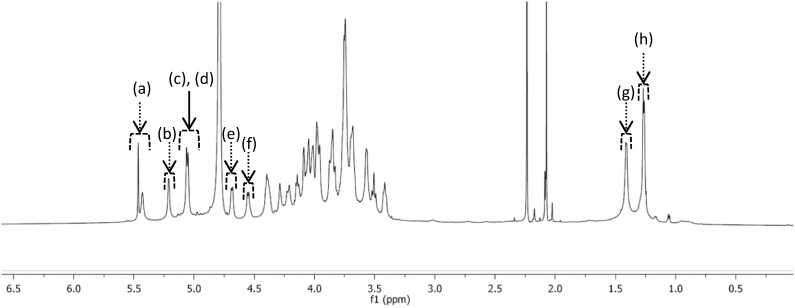

1H NMR analysis of dried extract from K. pneumoniae supernatant at 40 g.L−1 in D2O (99.99% D).Analysis was recorder at 60°C using a Brucker Advance spectrometer (600 MHz). (a) = H-1 of [→2,3)-α-d-Galp-(1→] residue; (b) = H-1 of [α-d-Galp-(1→] residue; (c) = H-1 of [→4)-α-l-Rhap-(1→] residue; (d) = H-1 of [→2)-α-l-Rhap-(1→] residue; (e) = H-1 of [→4)-β-d-GlcAp-(1→] residue; (f) = H-1 of [→3)-β-d-Galp-(1→] residue; (g) = H-6 of [→4)-α-l-Rhap-(1→] residue; (h) = H-6 of [→2)-α-l-Rhap-(1→] residue.